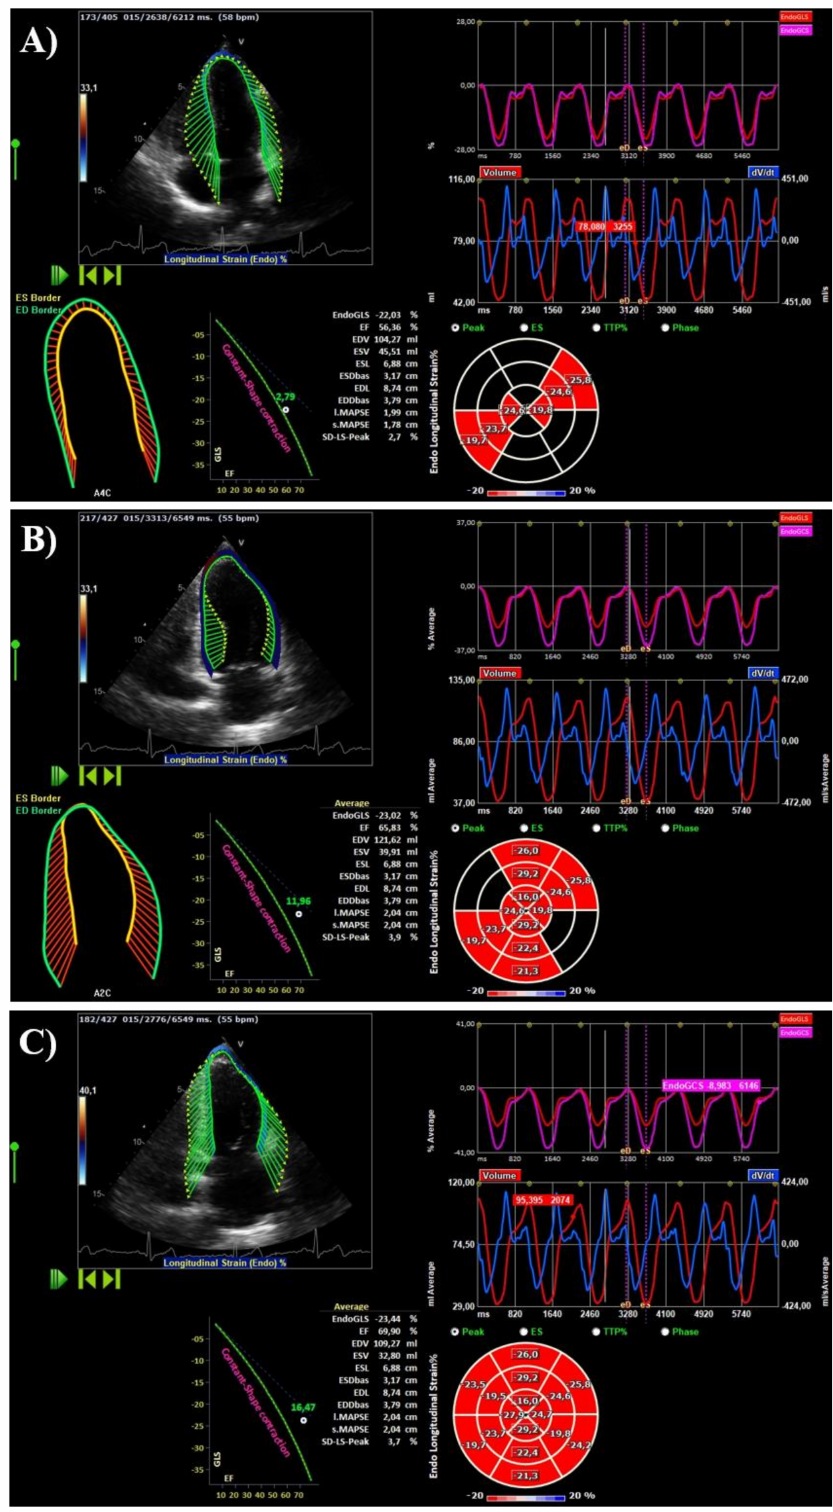
Figure 1. Post processing steps. ( A ) Analysis of apical 4 chamber view with vector velocity imaging, representation of endo GCS and GLS, variation of volumes and dV/dt, segmental longitudinal strain showed as bull-eye. ( B ) Analysis of 2 chamber view. ( C ) Analysis of 3 chamber view with average data. GCS, global circumferential strain; GLS, global longitudinal